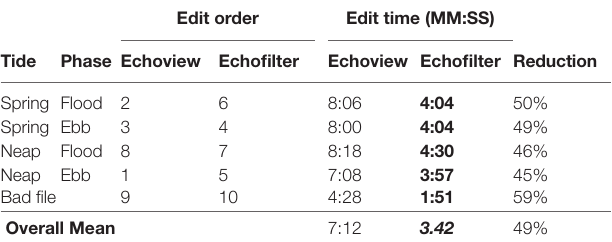
TABLE 6 | Results from the time-to-edit